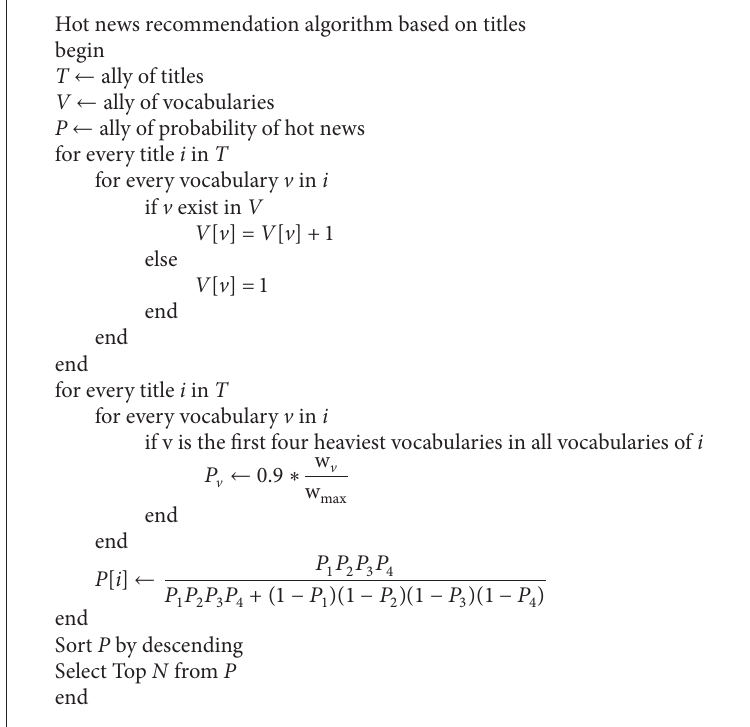
Hot news recommendation algorithm based on titles